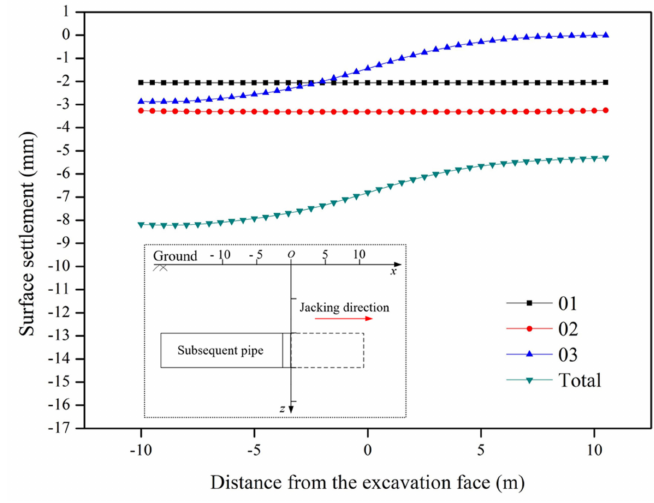
Figure 14. Curves of longitudinal ground surface